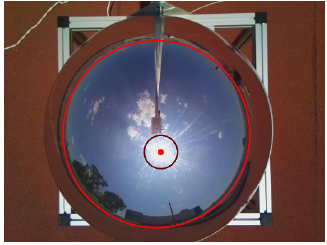
Figure 6. Sun detection